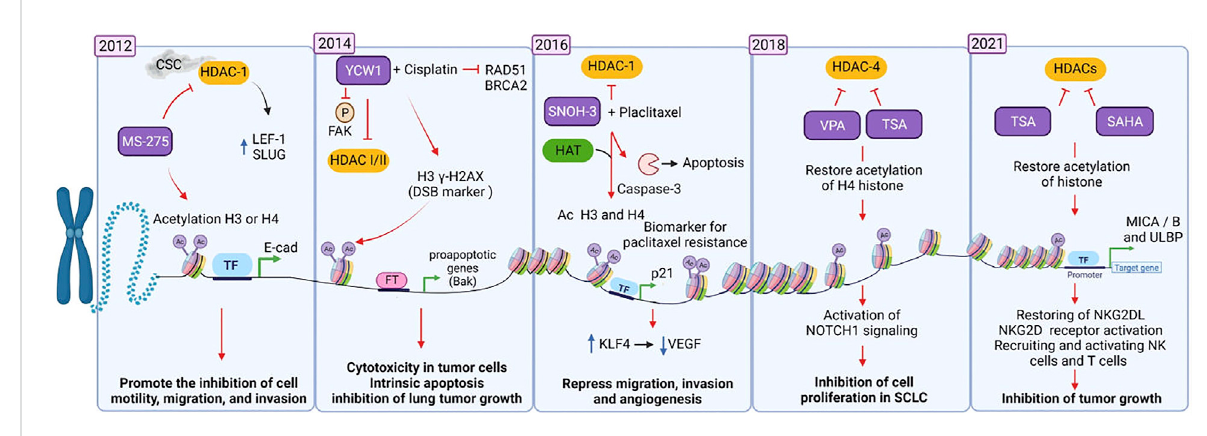
FIGURE 1 The differentstates ofchromatinare epigeneticallyregulated byHDACs andHDACinhibitors,whichdetermine thetranscriptionalactivation or silencing of genes involved in lung cancer development. Studies from 2012 to 2021 showing the role of HDACs and HDAC inhibitors in the development of therapies against lung cancer. Created with biorender.com CSC, cigarette smoke condensate; iHDACs (MS-275, YCW1,